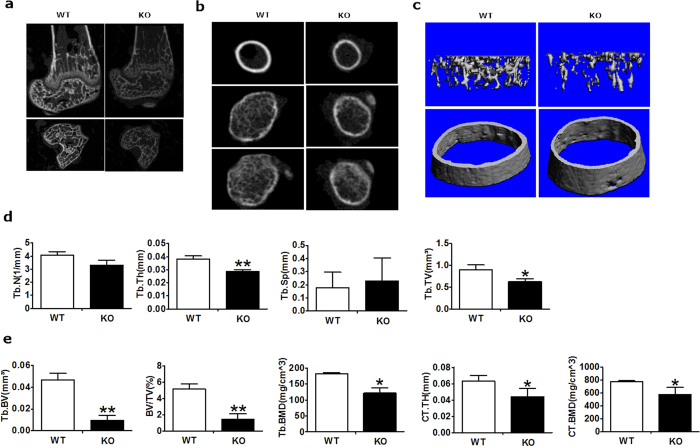
Bone mass was reduced in the distal femur of PKD1 KO mice by micro-CT analysis.(a) Less difference of bone mass between WT and KO mice by representative micro-CT images of the distal femur (upper panel) and the structure of metaphyseal (lower panel) trabecular bone. (b) Micro-CT images of cortical bone in the mid-diaphysis (upper panel) and trabecular bone in the metaphysis (middle and lower panel). (c) Three-dimensional models images of micro-CT analyses of the structure of metaphyseal trabecular bone and cortical bone in the distal femur. (d,e) Quantitative micro-CT analyses of cortical and trabecular structure at the distal femur. Measurements were trabecular number (Tb.N), trabecular thickness (Tb.Th), trabecular (Tb) tissue volume (TV), bone volume (BV) and bone volume fraction (BV/TV), trabecular separation (Tb.Sp), bone mineral density (Tb.BMD), cotircal bone mineral density (Ct.BMD) and Cortical thickness (Ct.Th) (n = 3), WT or KO mice at 4 weeks old. Measurements are presented as mean ± SD. *p < 0.05 versus respective control.